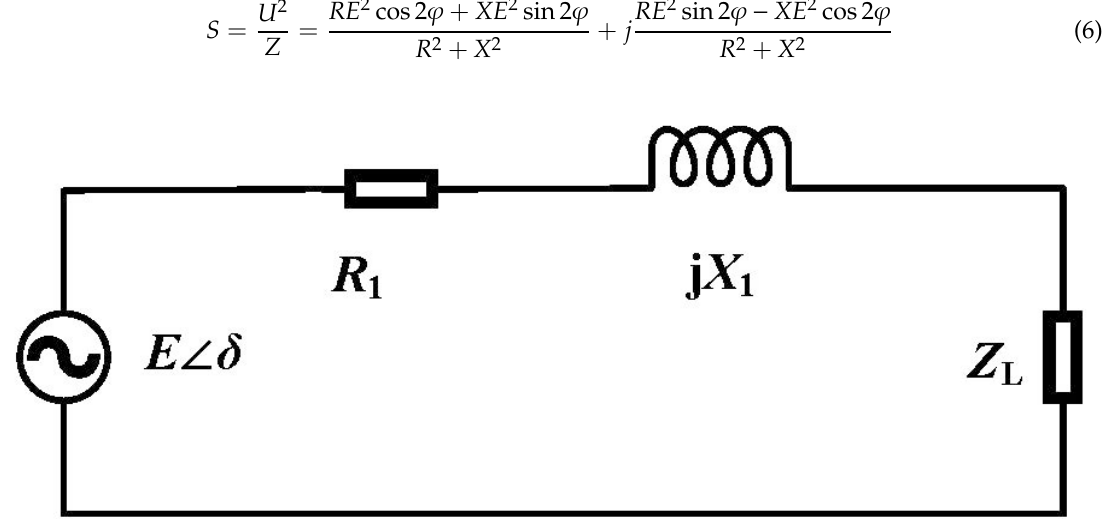
Figure 4. Equivalent circuit of the inverter under island mode.